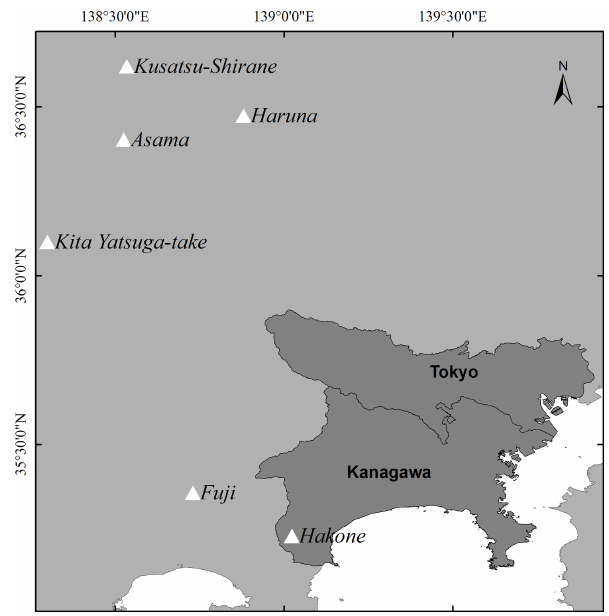
Figure 1. The geographic domain of the volcano ash fall model pre- sented in this paper includes the Tokyo and Kanagawa prefectures in Japan and the six major volcanoes that can affect them: Fuji, Hakone, Asama, Haruna, Kita-Yatsugatake, and Kusatsu-Shirane. Table 1. Number of volcanic ash fall events included in the model (i.e. those ash fall events that impact the model’s geographical do- main of the Tokyo and Kanagawa prefectures) and associated an- nual probabilities of occurrence by volcano. Ash fall events origi- nated by these volcanoes that do not impact the model domain have been excluded from the